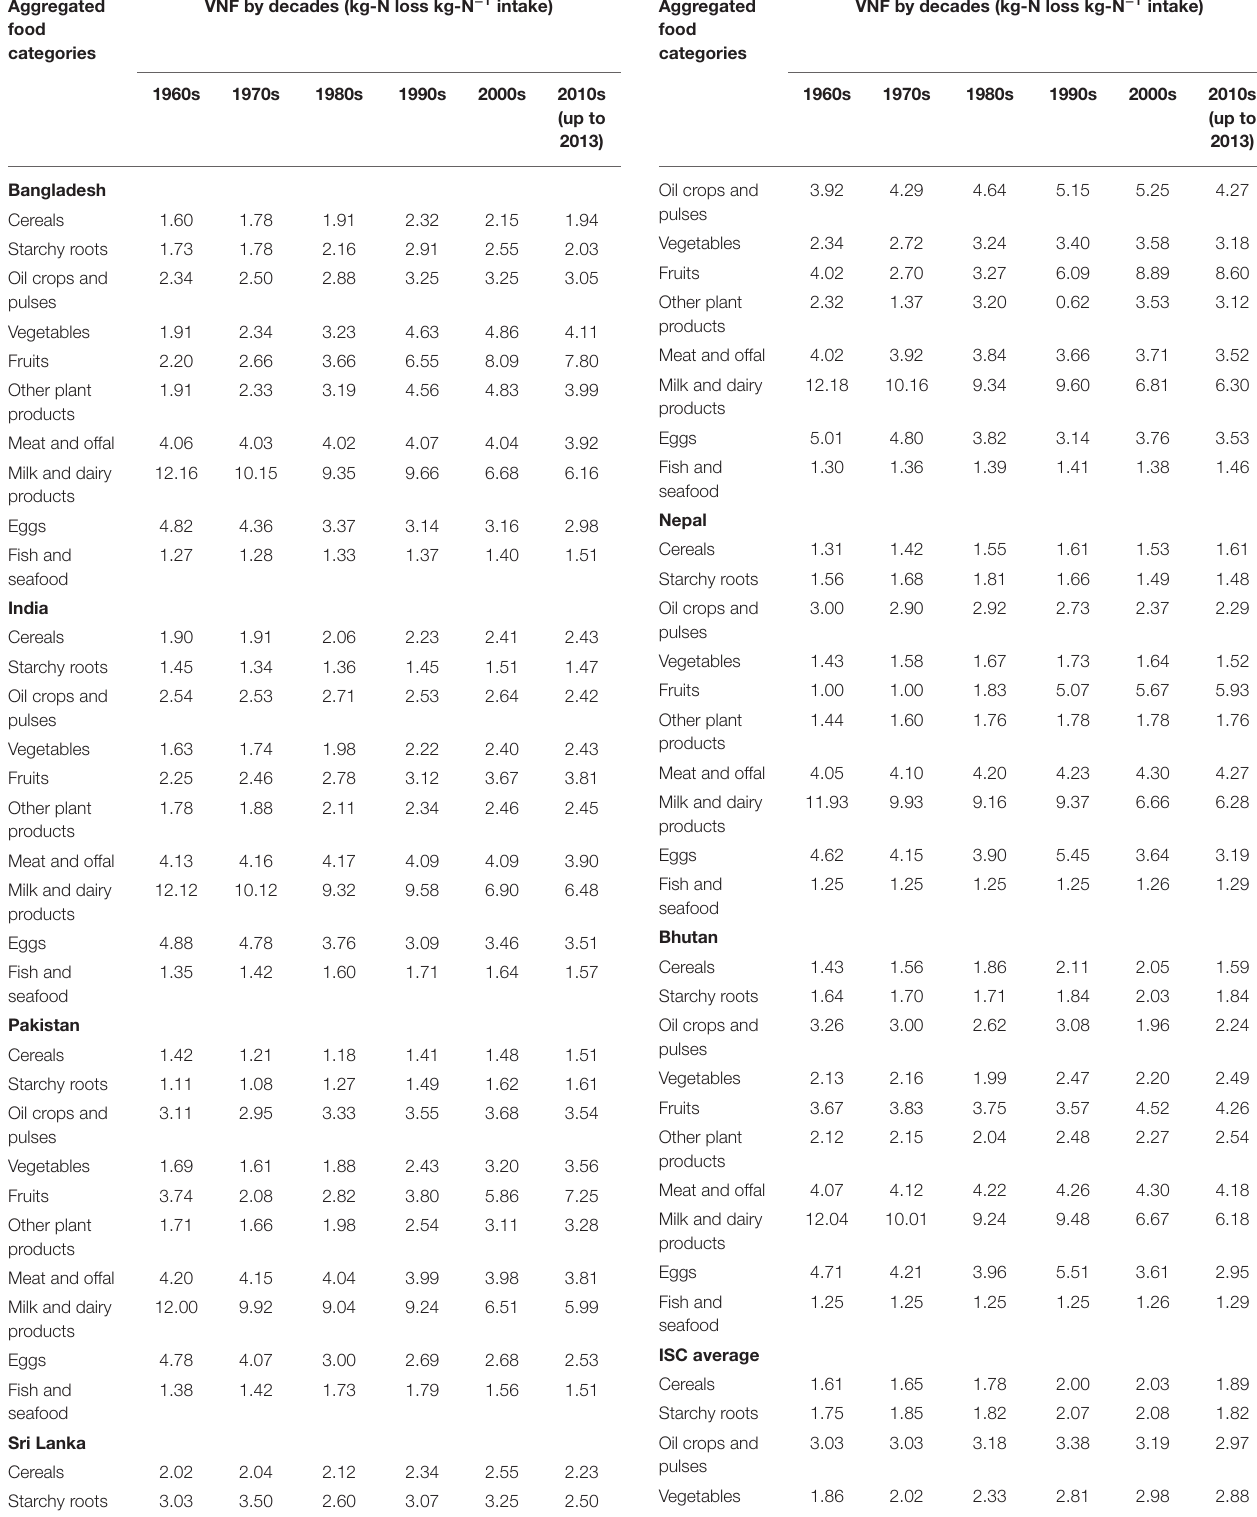
TABLE 1 | Trade-considered VNFs of the